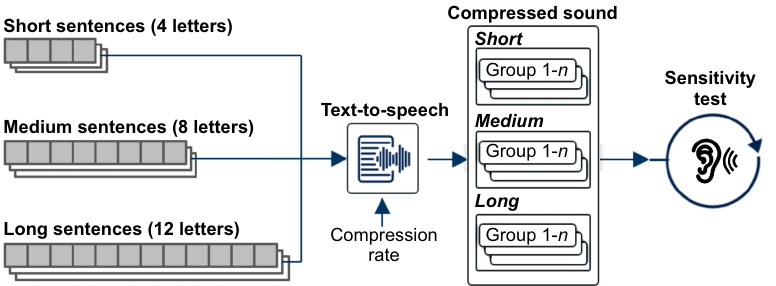
Figure 4. Procedure for the preliminary experiment. Each group of compressed sound corre- sponded to a predefined compression ratio. In the experiment performed, we used six different compression ratios ( n =